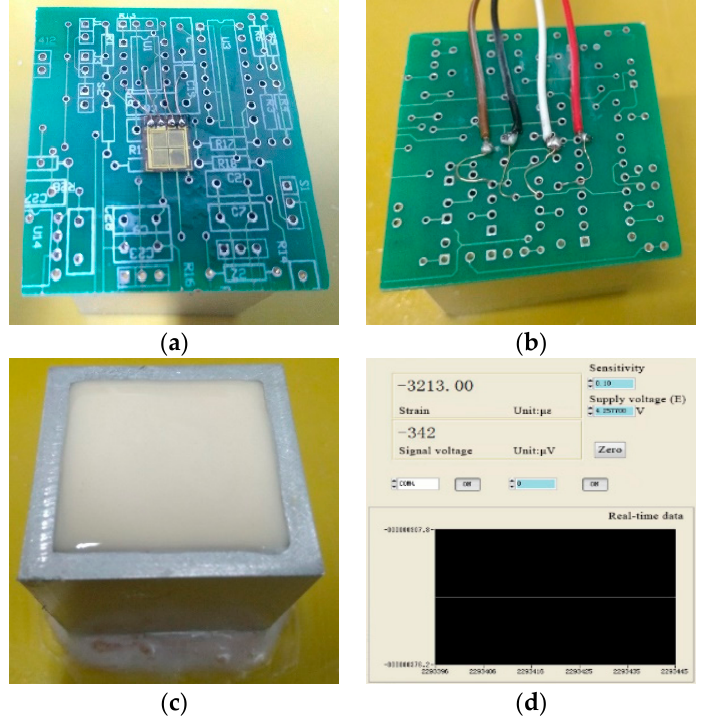
Figure 2. Test device for shrinkage stress of the potting adhesive: ( a ) Strain gauge on the printed circuit board (PCB); ( b ) Wires on the PCB; ( c ) Potting adhesive inside the test device; ( d ) Data acquisition